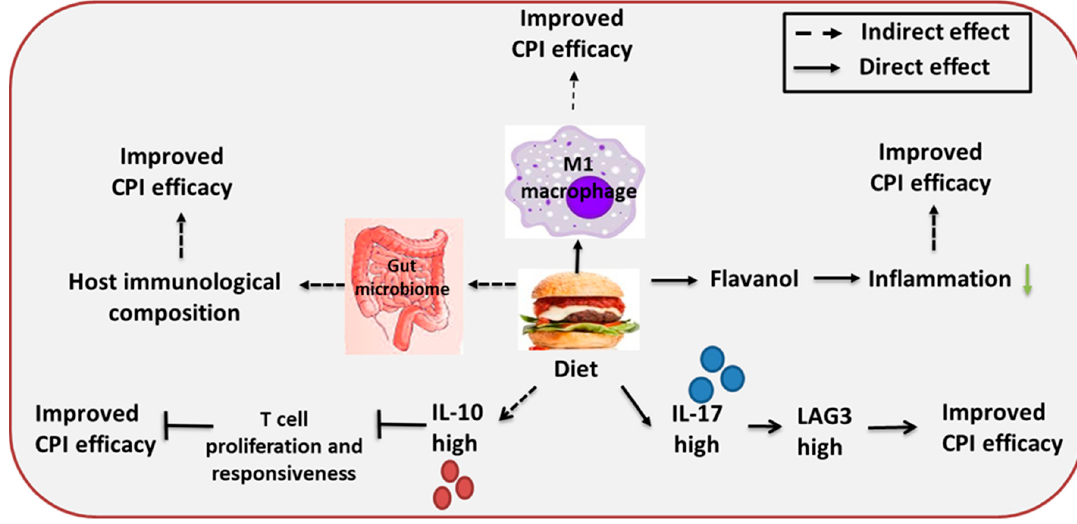
Figure 3. Effect of diet on CPI response. Figure 3. E ff ect of diet on CPI